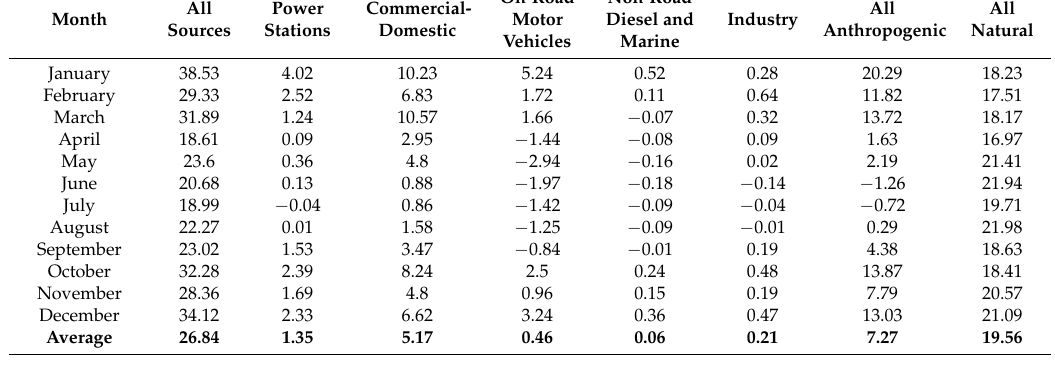
Table A1. Monthly average of daily maximum 1-hour predicted ozone concentration (ppb) in the Sydney west region for different months in 2008 under various emission scenarios.